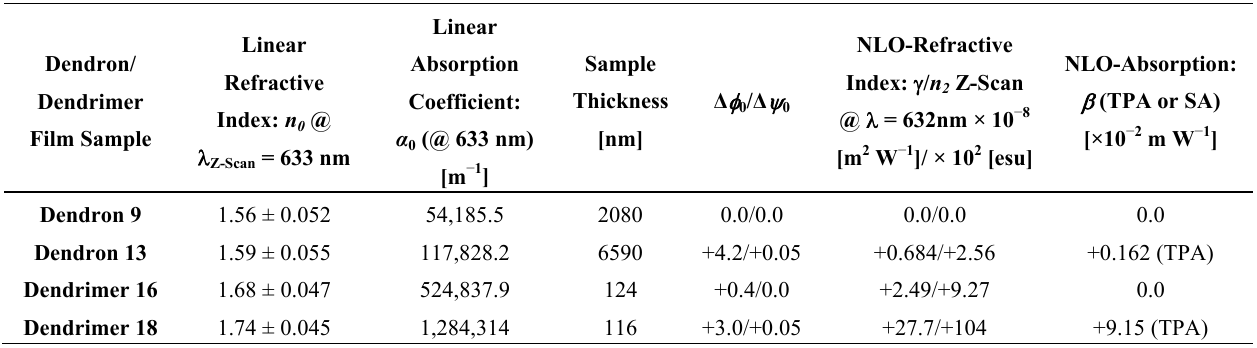
Table 2. Linear and cubic nonlinear optical parameters of the dendron/dendrimer-based films measured according to the Z-Scan technique (Closed aperture Z-Scan